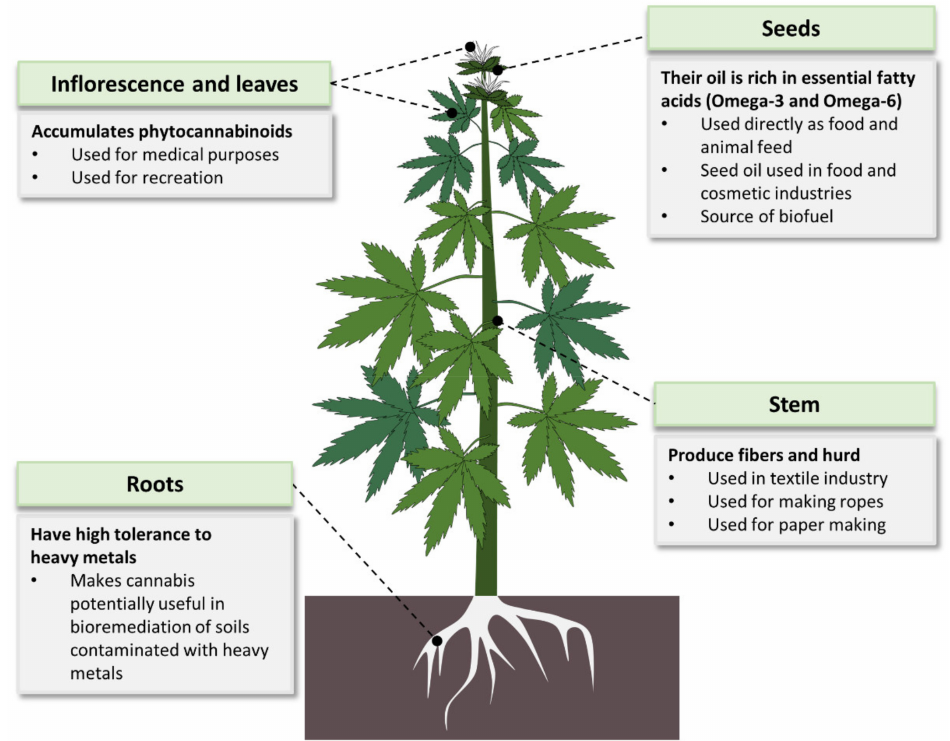
Figure 4. Cannabis usage: Almost all parts of the Cannabis plant can be used in one or more ways. The plant’s seeds are highly nutritious while its flowers accumulate medicinal secondary metabolites (phytocannabinoids). Cannabis stem is used for producing quality fibers, and its roots are efficient in